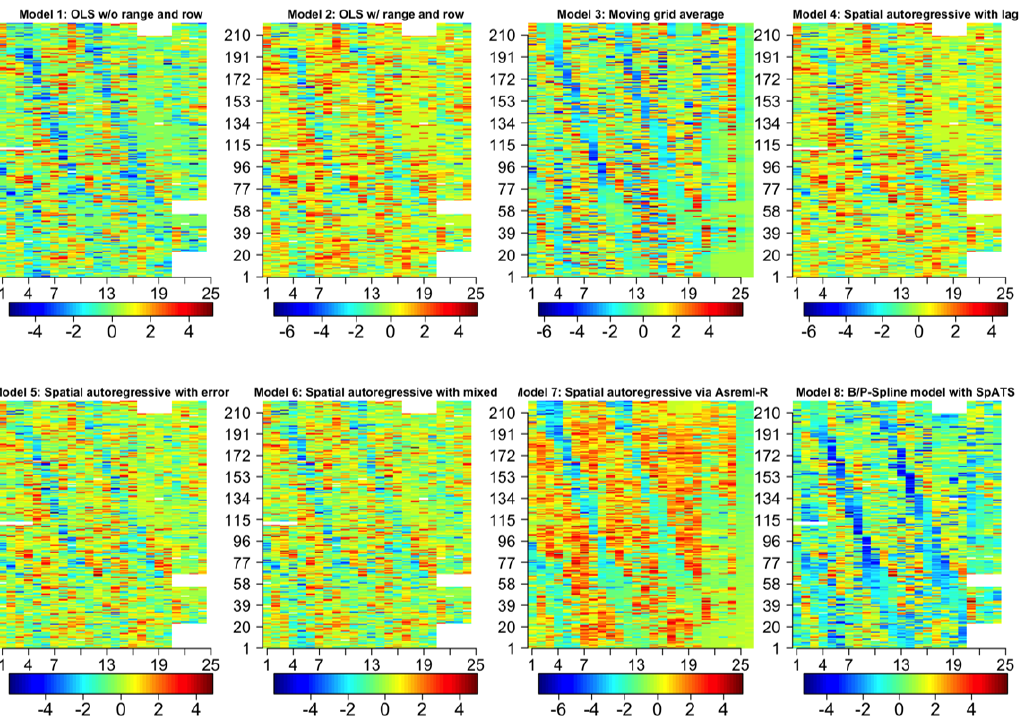
Figure 8. Heatmaps of residuals from data set 2 derived from the eight models. Each of the images has 220 ranges by 26 rows. The X-axis is the row and the Y-axis is the range. The numbers under the legend bars are the range of residual values, and the numbers above the legend bars in the bottom half of the figure are the row numbers.